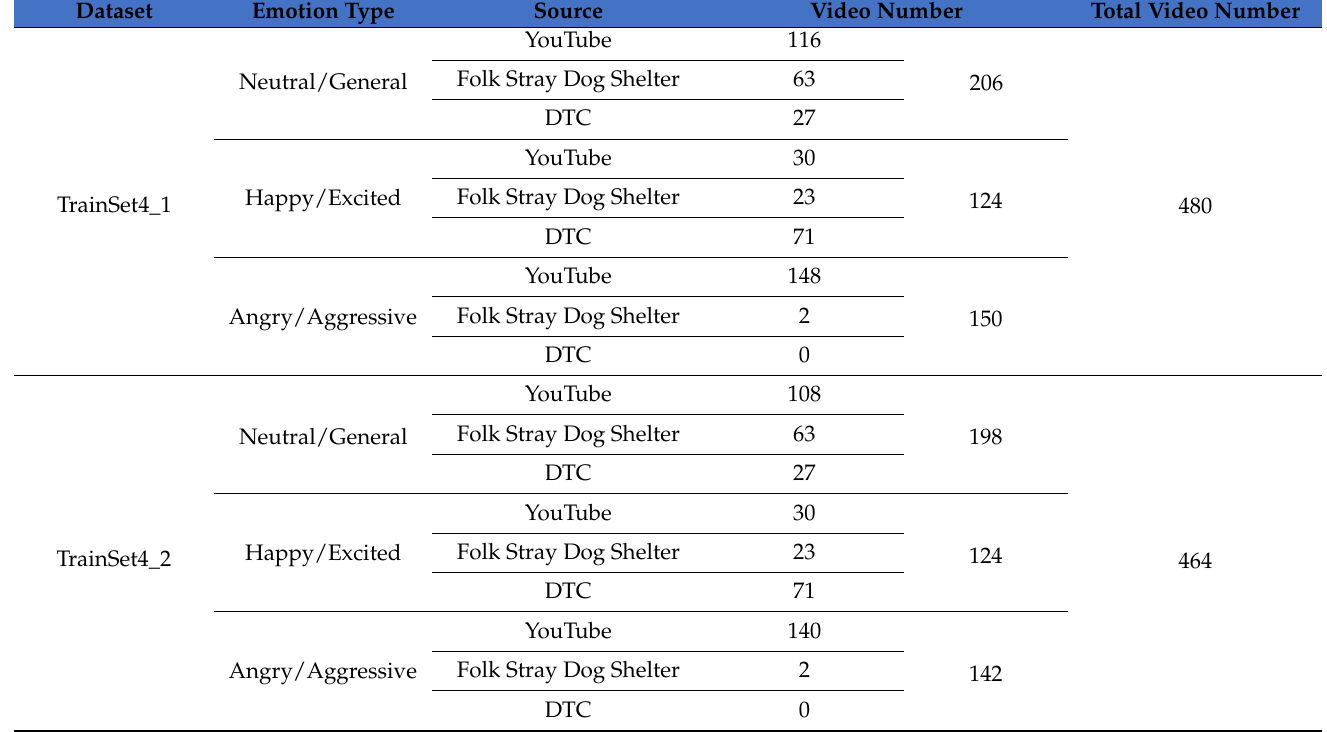
Table 7. Training data-set for dog emotion recognition model.